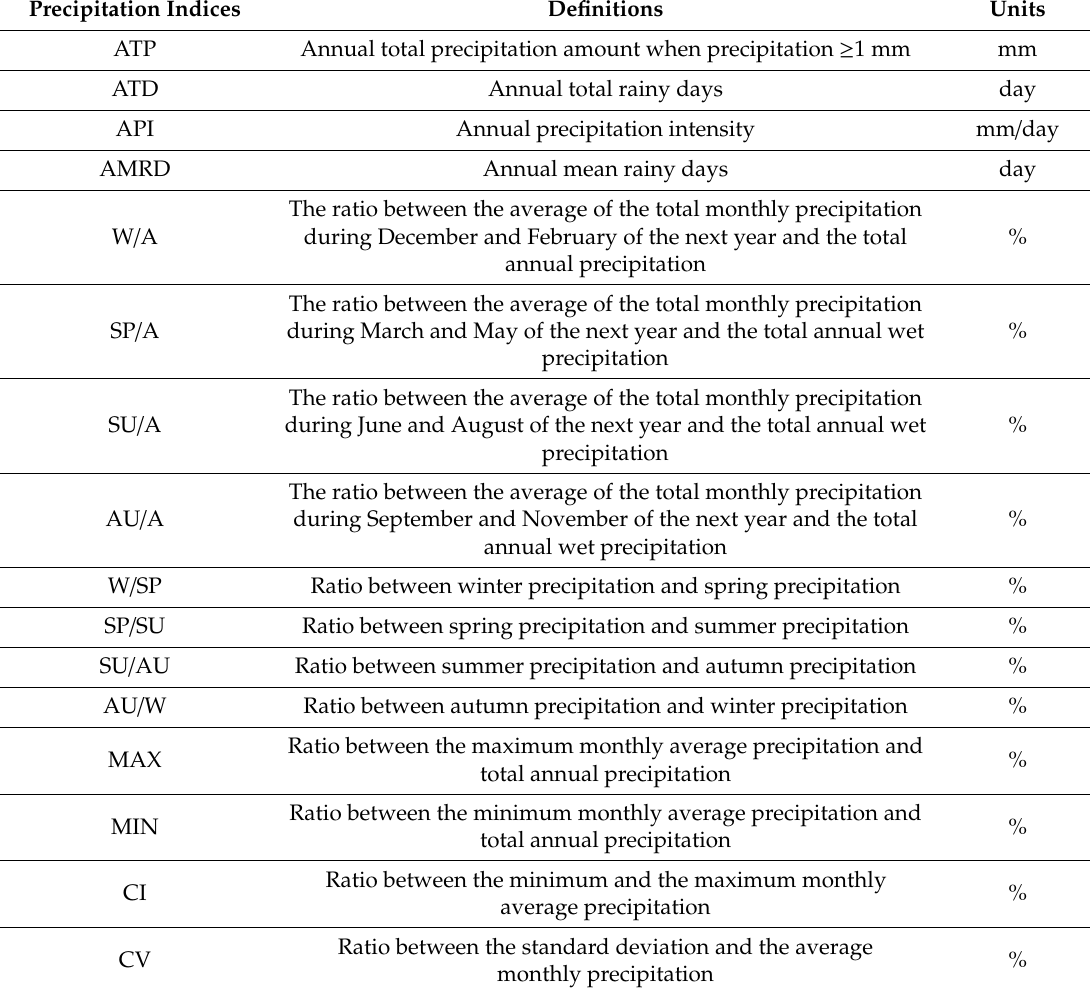
Table 3. Definitions of precipitation indices (Zhang, et al.